Question: Draft a figure caption describing what is shown.
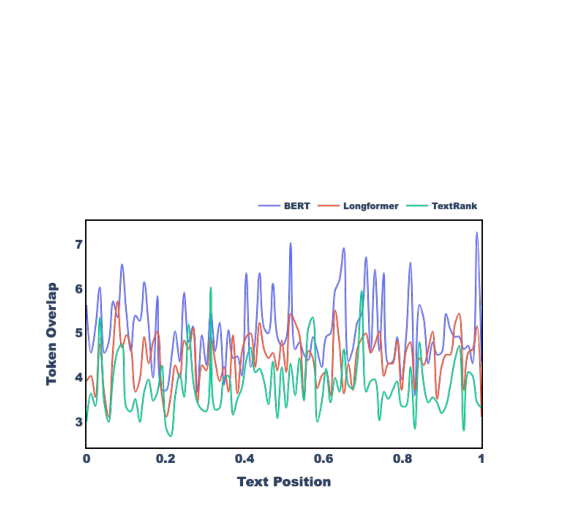
Answer: Average token overlap between shuffled system-generated summaries by each of the three ex- tractive summarization models and each document di in the input set D of DivSumm. Text position on the x-axis has been normalized between 0 and 1.